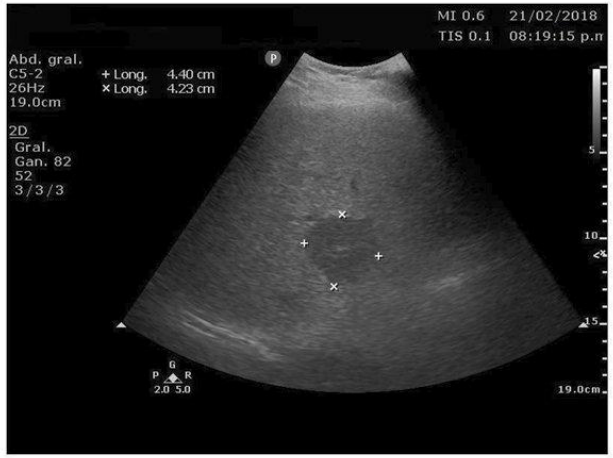
Figure 1: FNH features on conventional B-mode ultrasound: a hypoechoic image of poorly defined borders is observed in the right hepatic lobe.